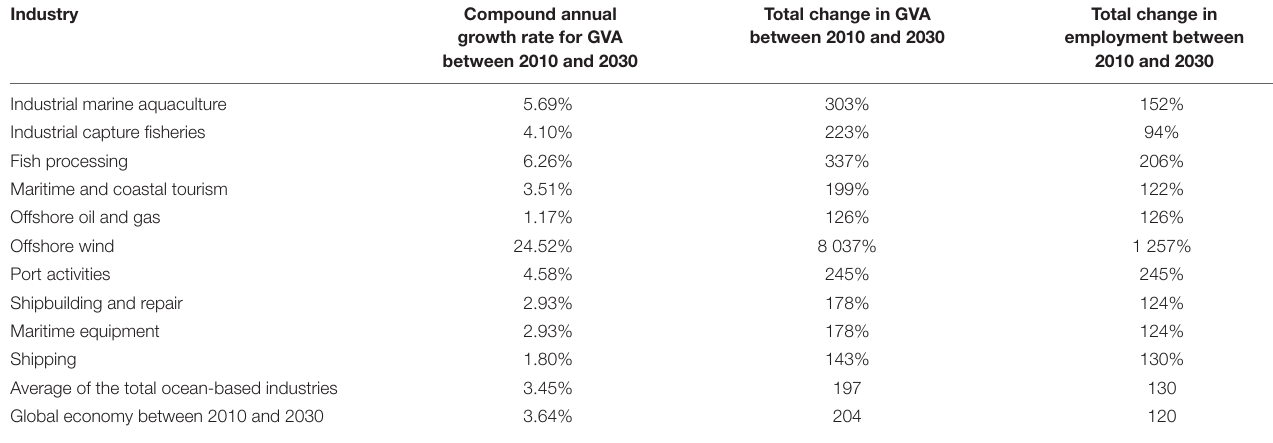
TABLE 2 | Overview of estimates of industry-specific growth rates in value added and employment 2010 and 2030 (OECD, 2016).